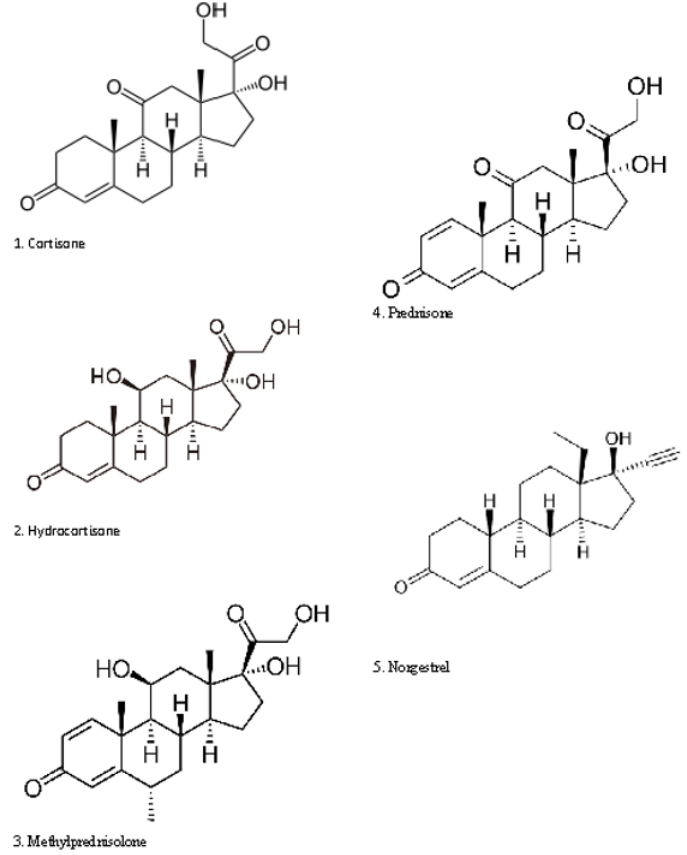
Figure 1. Structure of selected